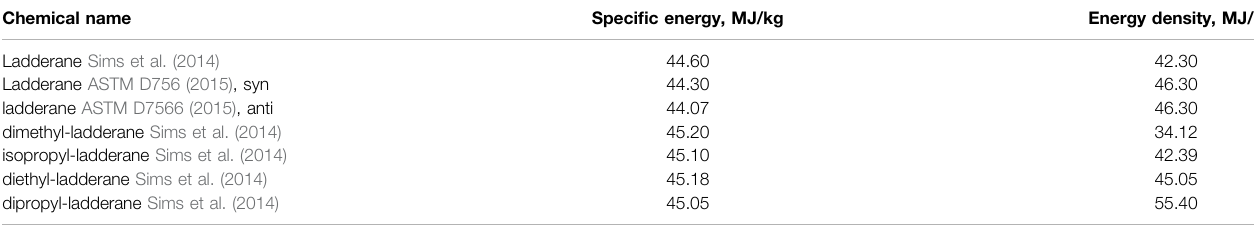
TABLE 5 | Physical properties of ladderanes and their derivatives analyzed in this work. Chemical name